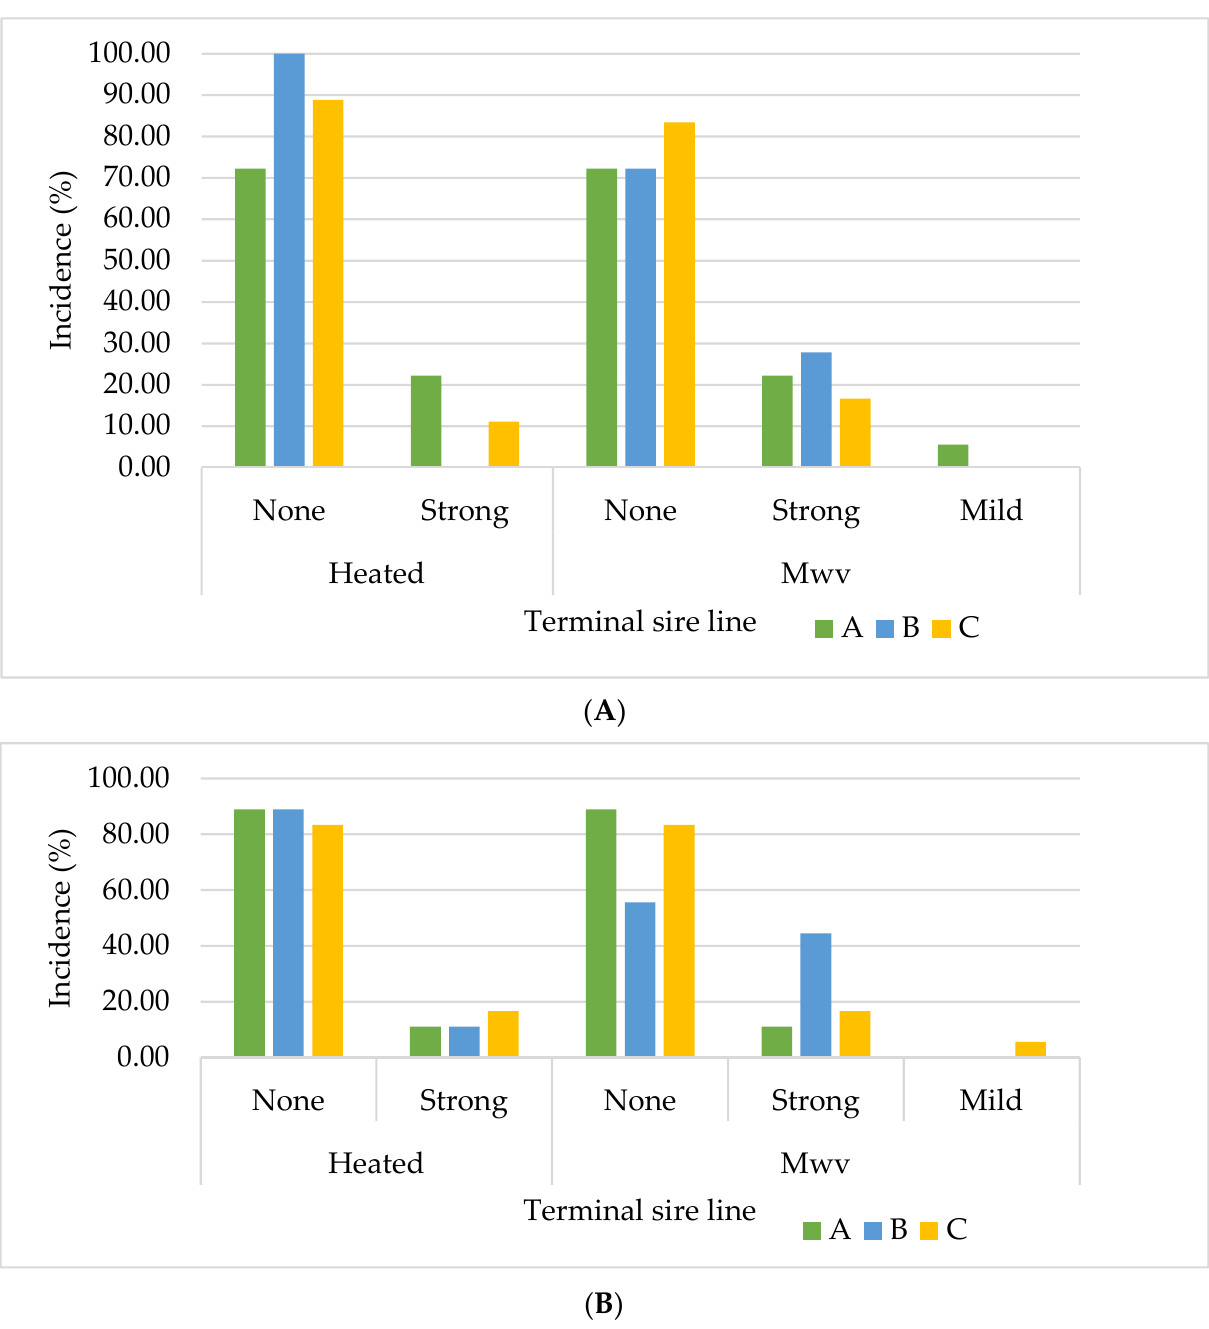
Figure 5. The incidence of boar taint odour of the ( A ) immunocastrates and ( B ) entire males samples originating from three terminal sire lines using hot water (heated) and microwave (mwv) method.